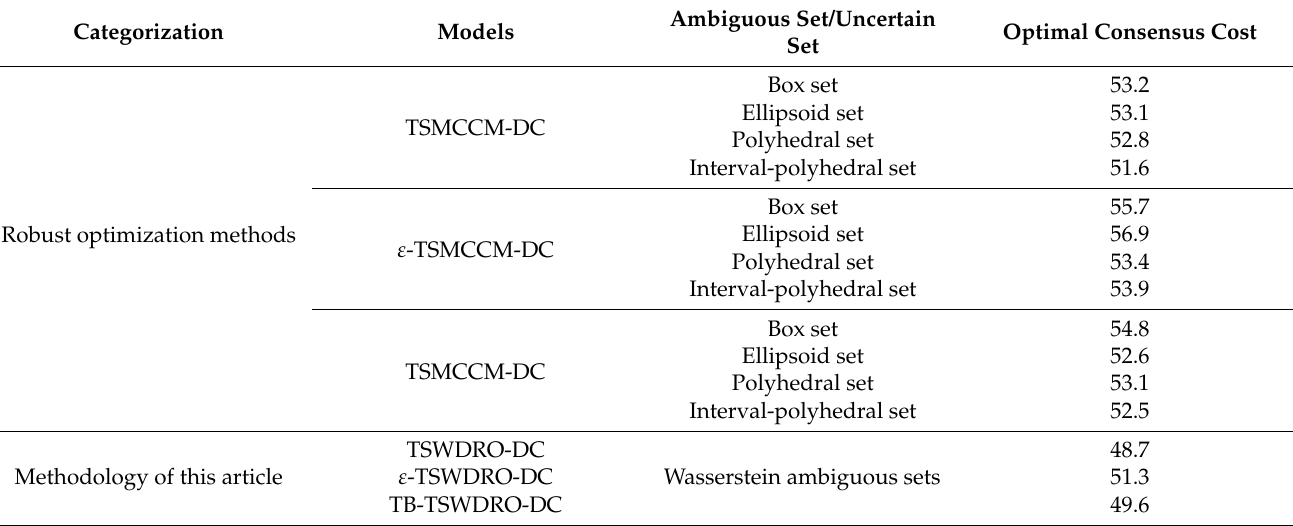
Table 4. Comparison of optimal results of different cost consensus